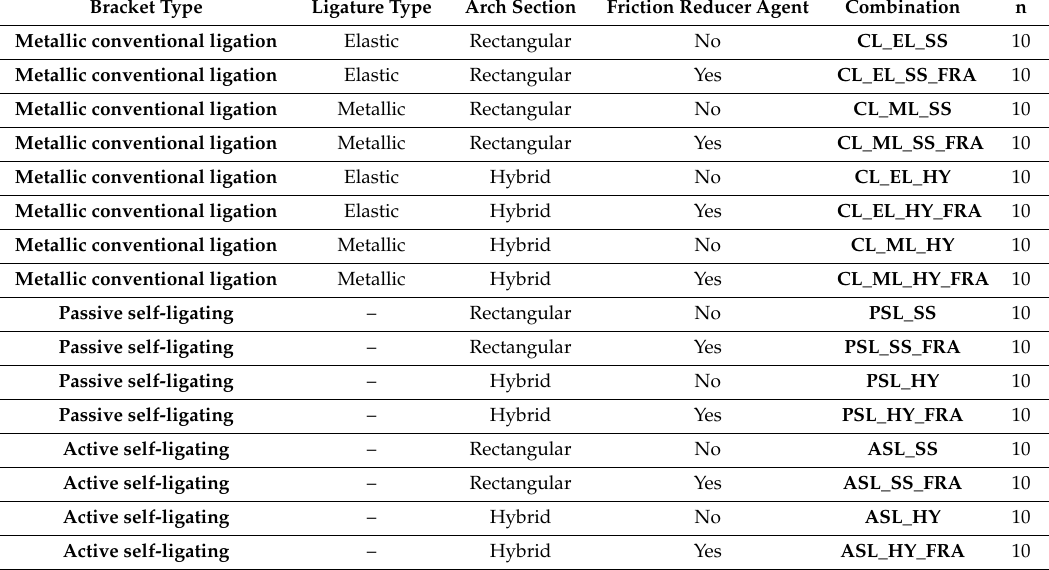
Table 9. Group distribution according the di ff erent studied